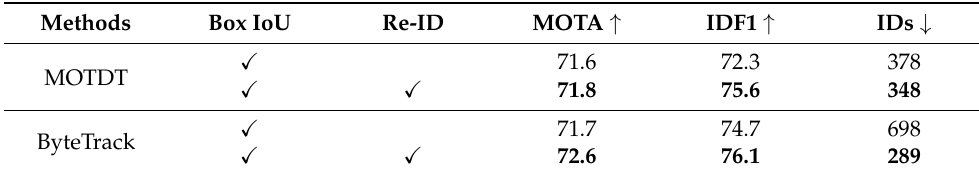
Table 5. Evaluation of the two ingredients in MOTDT and ByteTrack. The best results are shown in bold